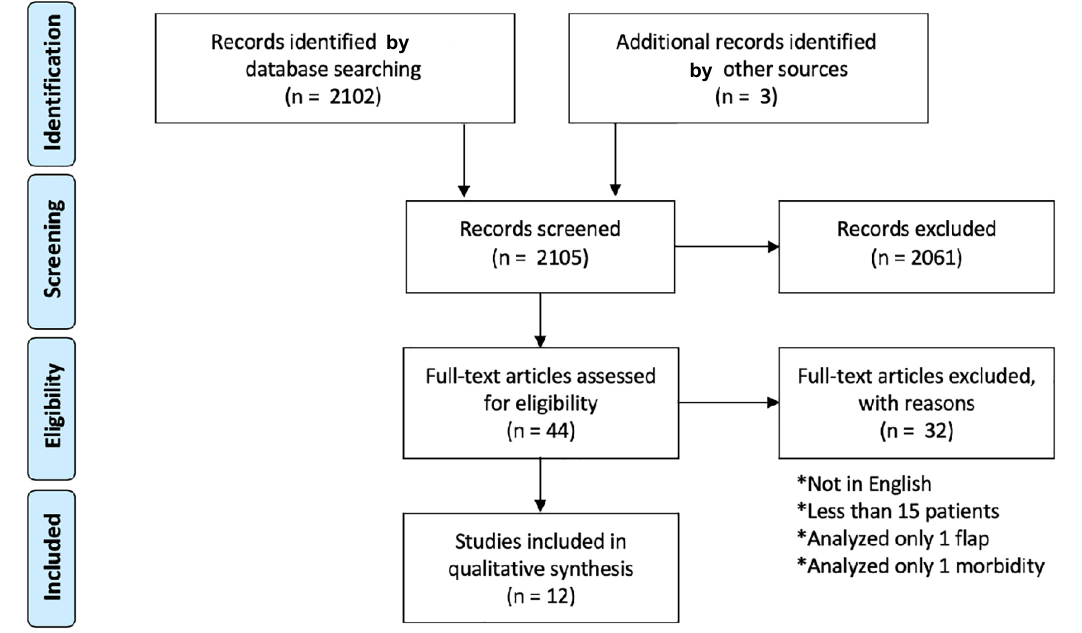
Figure 2- PRISMA Flow chart for the data selection